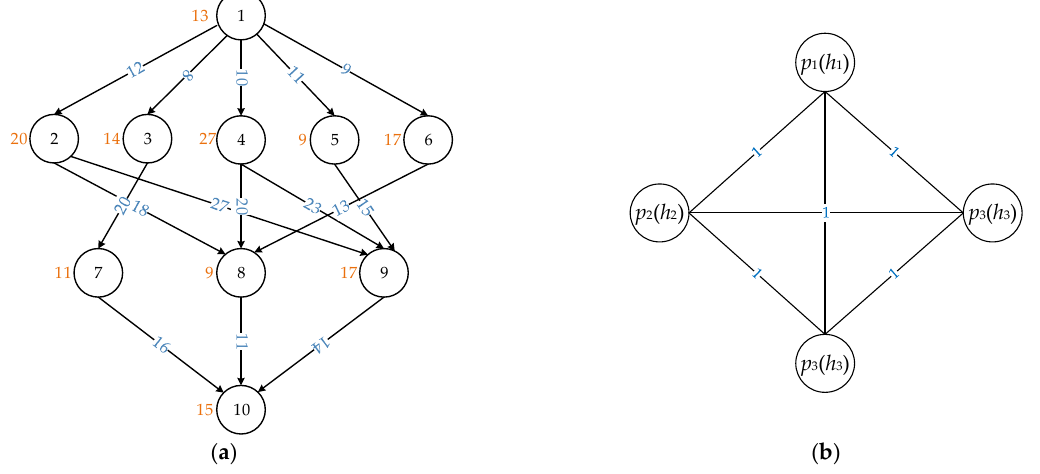
Figure 2. Platform scheduling model: ( a ) task scheduling model; ( b ) processing system model.